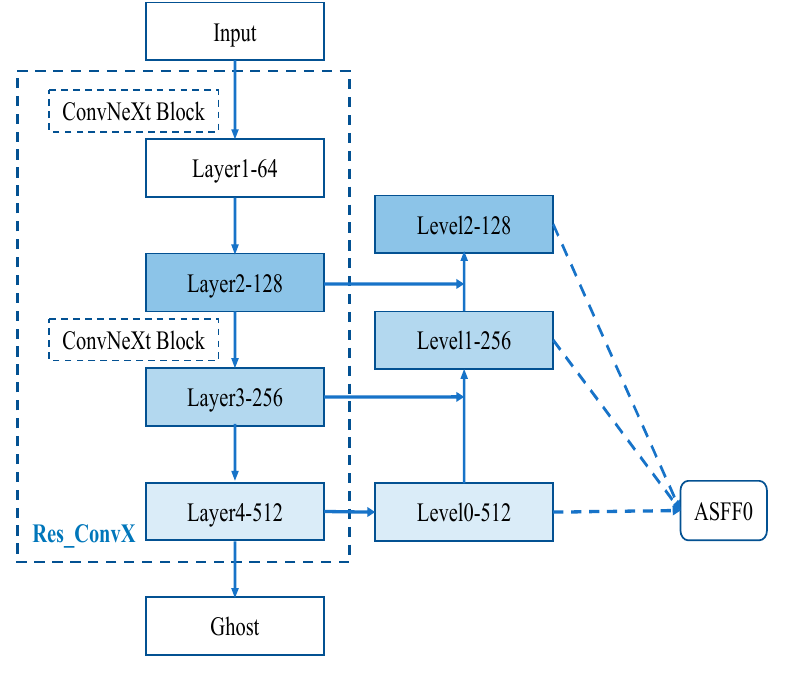
Figure 2. MainNet structure